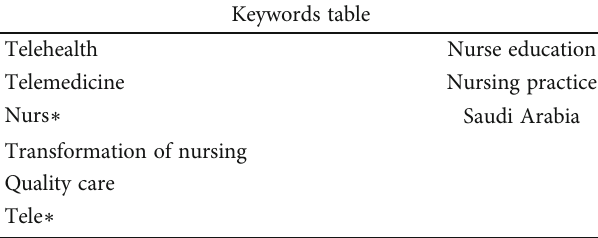
Table 2: Search terms used in the search